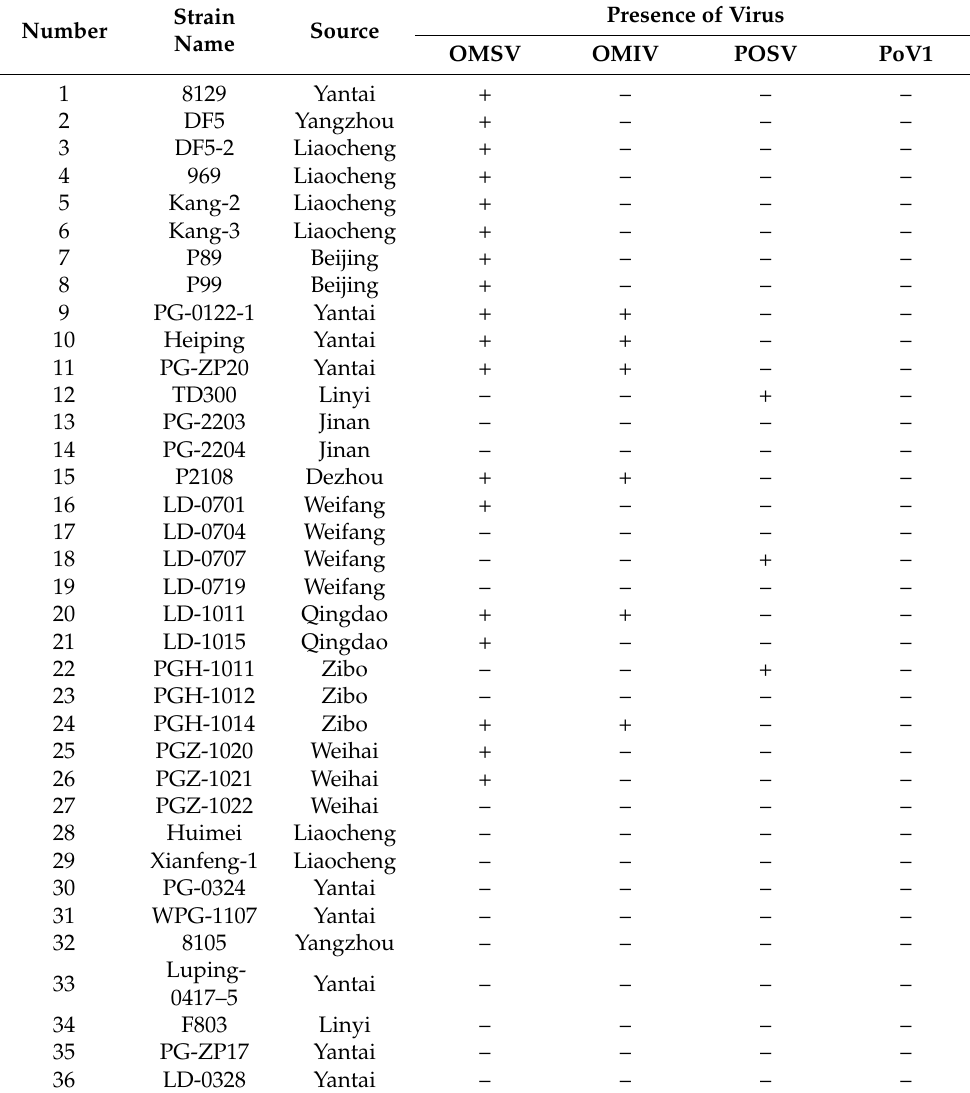
Table 2. The names, sources, and presence of viruses in this